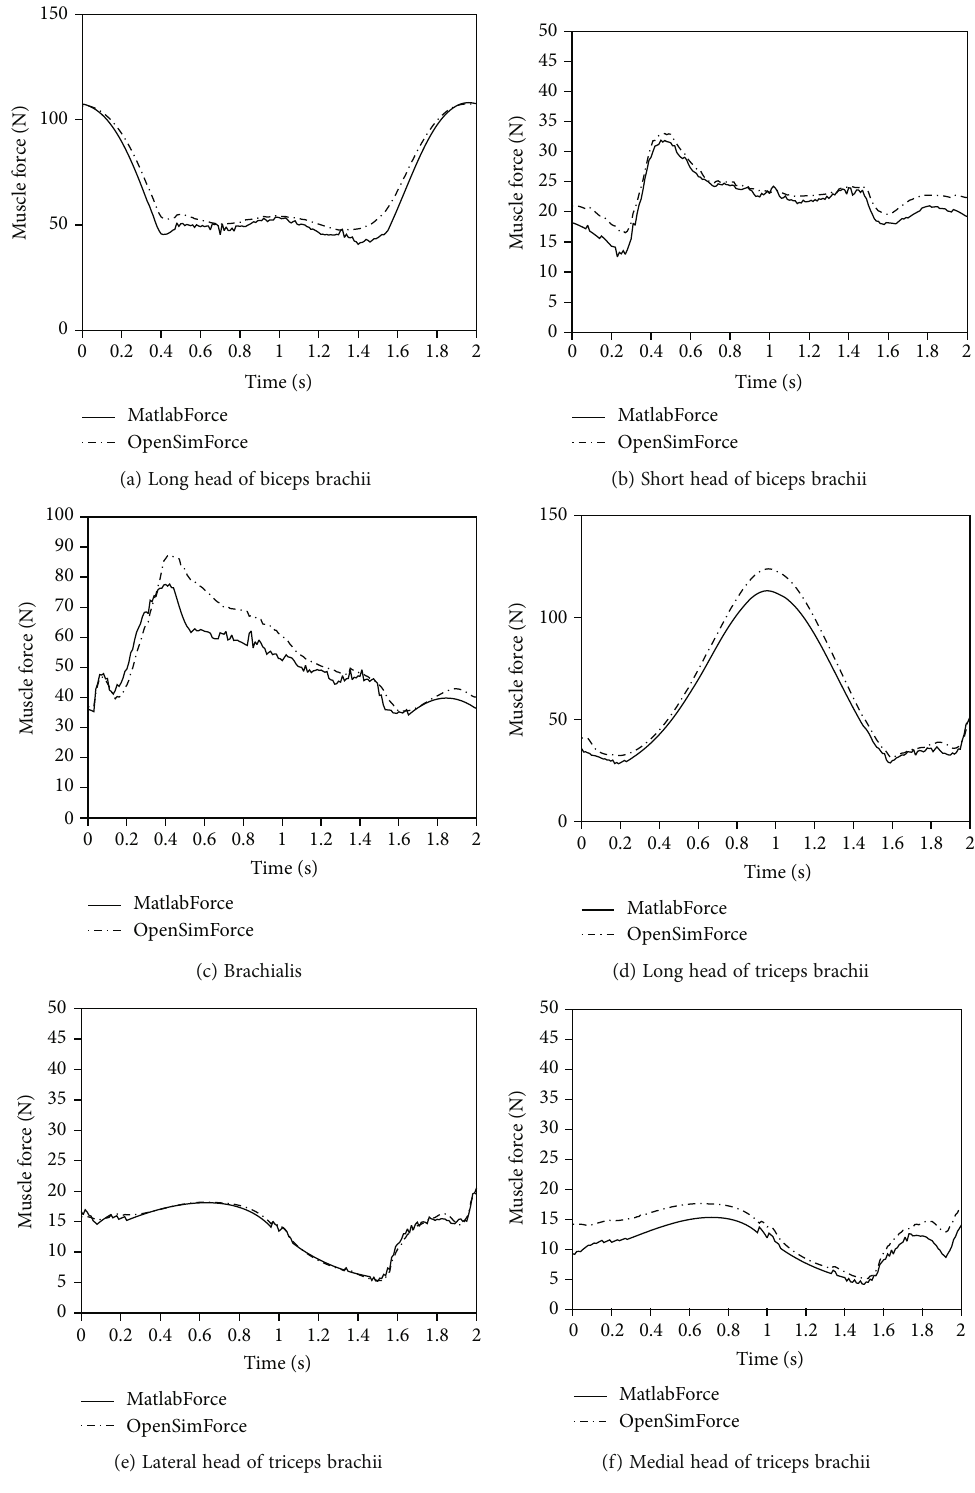
Figure 9: Muscle force and time relationship under the two